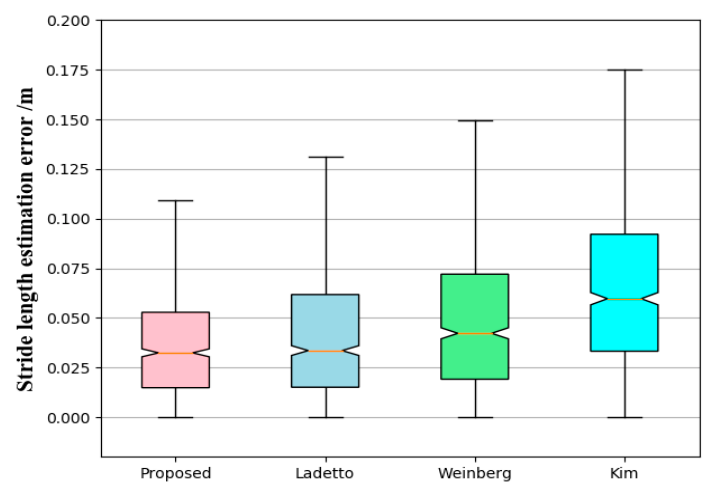
Figure 12. Box plot of stride-length estimation error. In this box plot, the whiskers represent the 99.3% coverage. On each box, the central (red) mark is the median, the edges of the box are the 25th and 75th percentiles.